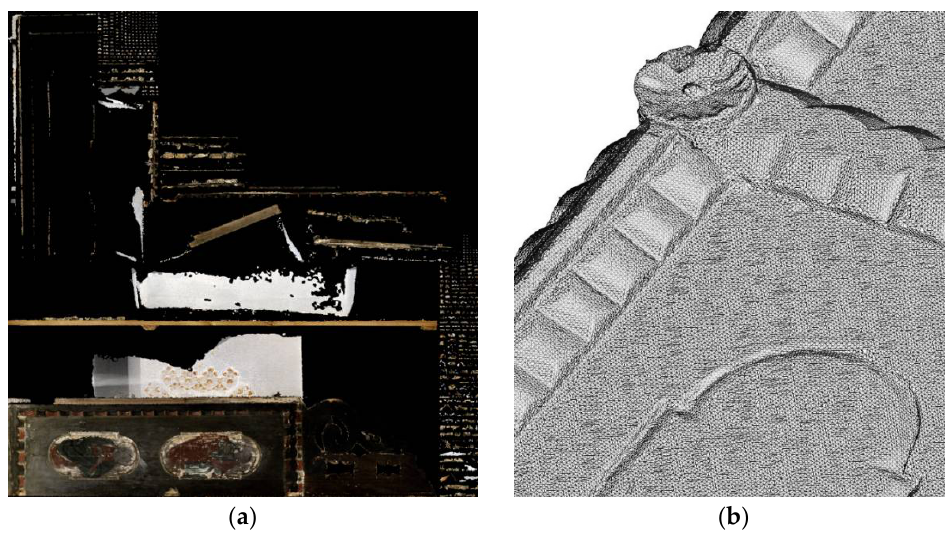
Figure 5. The texture ( a ) and the mesh resulted from processing ( b ).